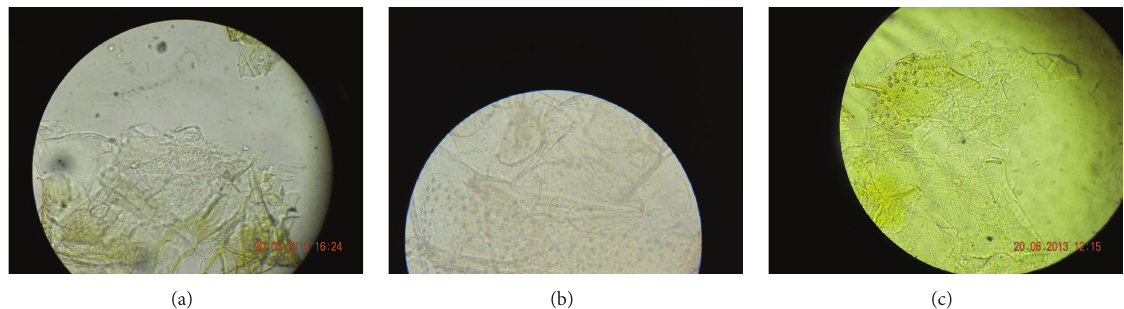
Figure 2: Female sand flies after dissection. ((a), (b)) Female genitalia spermathecal Phlebotomus sergenti; (c) Spermathecal Phlebotomus papatasi (personal photography; G × 40) .